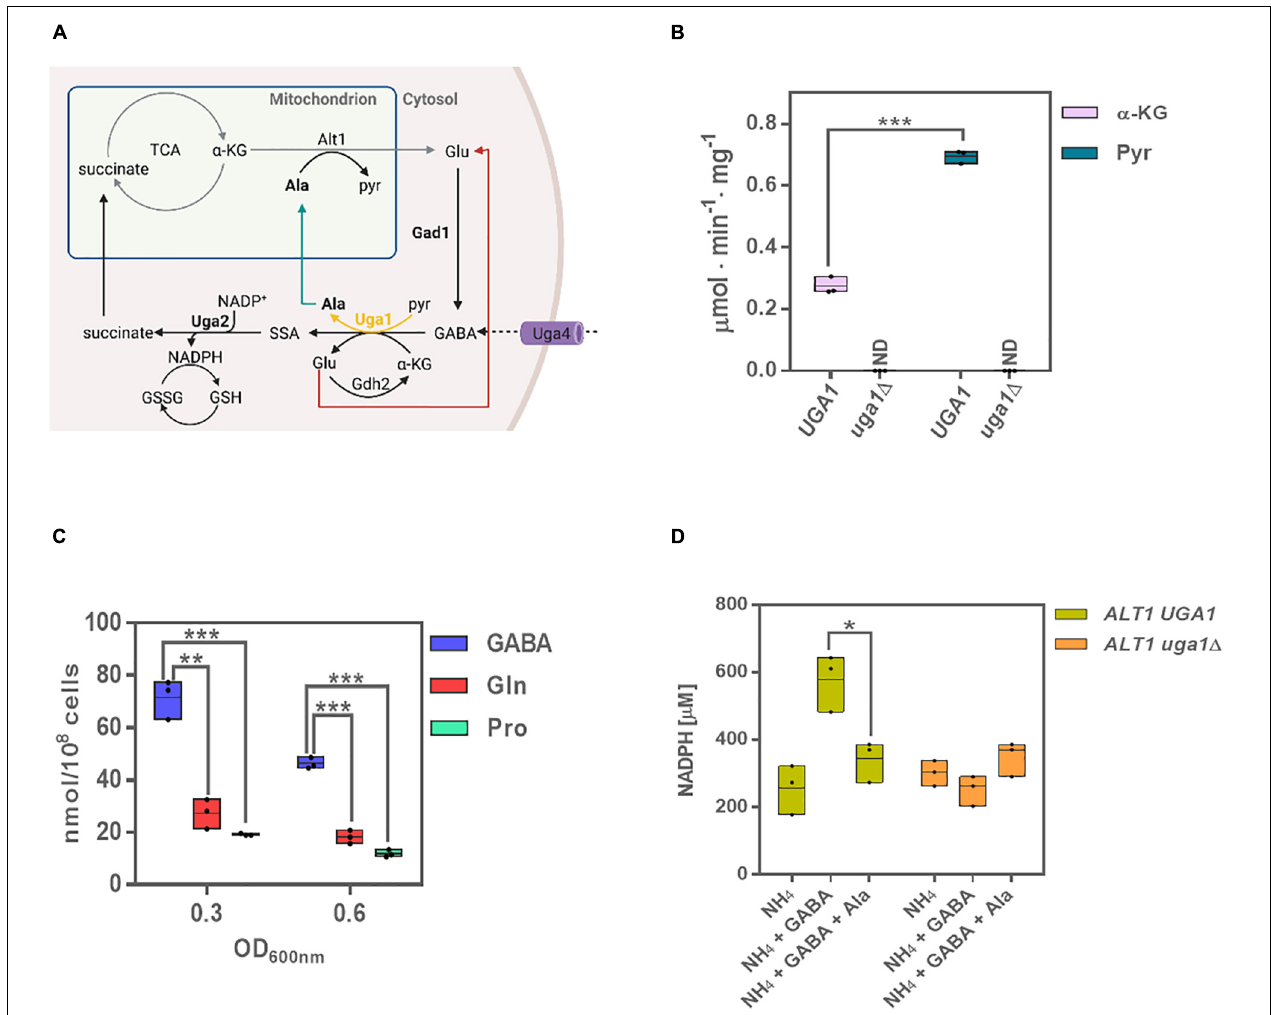
FIGURE 1 | Uga1 transaminase determines GABA-dependent alanine and NADPH biosynthesis. (A) The GABA shunt is constituted by three enzymes: Gad1 (glutamate decarboxylase), Uga1 (GABA transaminase), and Uga2 (SSADH). These enzymes are involved in the biosynthesis and catabolism of GABA: α -ketoglutarate ( α -kg), originated from the TCA cycle, is converted to glutamate (Glu); this may occur through Alt1 or Uga1; glutamate is then converted to GABA as a result of Gad1-dependent decarboxylation. GABA is also transported to the cell by Uga4 and catabolized by Uga1 to produce succinic semialdehyde (SSA) using α -kg or pyruvate (pyr) as substrates, rendering glutamate or alanine. Lastly, SSA is oxidized to succinate by Uga2 yielding NADPH, and succinate is assimilated by the TCA cycle. The utilization of α -kg or pyr by Uga1 can produce either glutamate or alanine (Ala). Ala is degraded by Alt1; its catabolism generates glutamate, which can be transported to the cytosol and restart the shunt. The glutamate produced by Uga1 may be catabolized by Gdh2 or reassimilated by Gad1. Image created with BioRender.com. (B) Enzymatic activity of Uga1 determined in extracts in glucose GABA during exponential phase using α -kg and pyr as substrates. The uga1 (cid:49) mutant was used as control and grown on ammonium + GABA as this strain does not grow on GABA as the sole nitrogen source. (C) Alanine intracellular concentration determined in GABA, glutamine (Gln) or proline (Pro) as nitrogen sources at OD 600 nm = 0.3 and 0.6 during exponential growth phase. (D) NADPH determination in glucose as carbon source and the indicated nitrogen sources at OD 600 nm = 0.6 for the wild-type and uga1 (cid:49) strains. Boxes show individual values (points) and the average (middle line) ± SE of three independent experiments. Asterisks indicate significant differences [*** P < 0.001, ** P < 0.01, and * P < 0.05, t -test